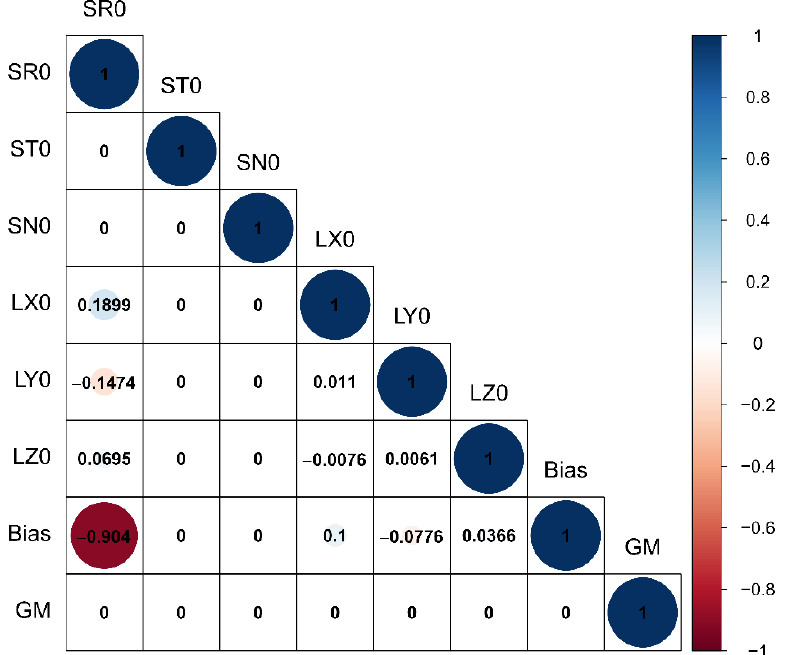
Figure 5. Same as Figure 4, but the Rosetta S/C corrections [SX0 SY0 SZ0] are mapped to the Radial (SR0), Transverse (along-track ST0), and Normal (cross-track SN0) directions with respect to the Rosetta S/C orbit.